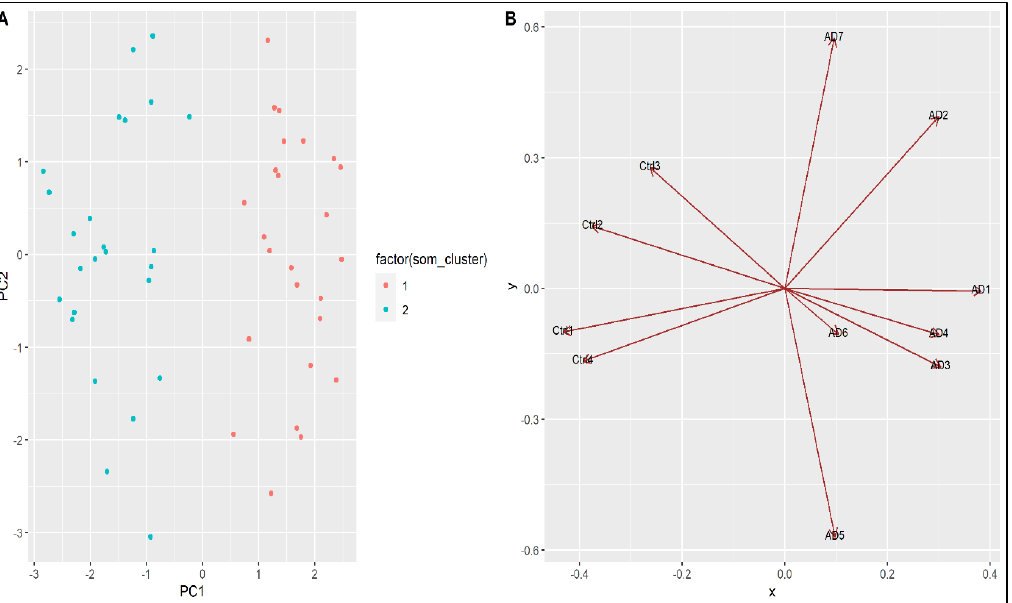
Figure 3. PCA plot of ( A ) clusters of top 50 ranked miRNAs based on SOM; ( B ) sample distribution corresponding to PCA: x -axis = PC1, y -axis = PC2.